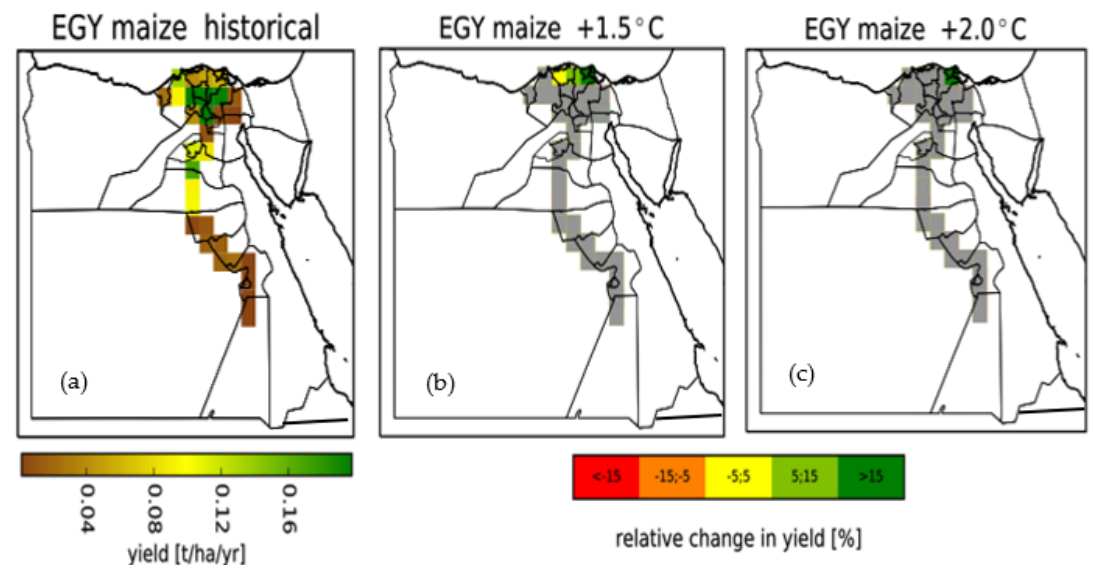
Figure 7. The historical maize yield in the 2000s and the future ISI-MIP relative change under GW1.5 and GW2.0 levels, ( a ): EGY maize historical; ( b ) EGY maize +1.5 °C; ( c ): EGY maize +2.0 °C. The grey grid cells where the models do not agree in the sign of change under each warming level, and this belongs to the uncertainty.